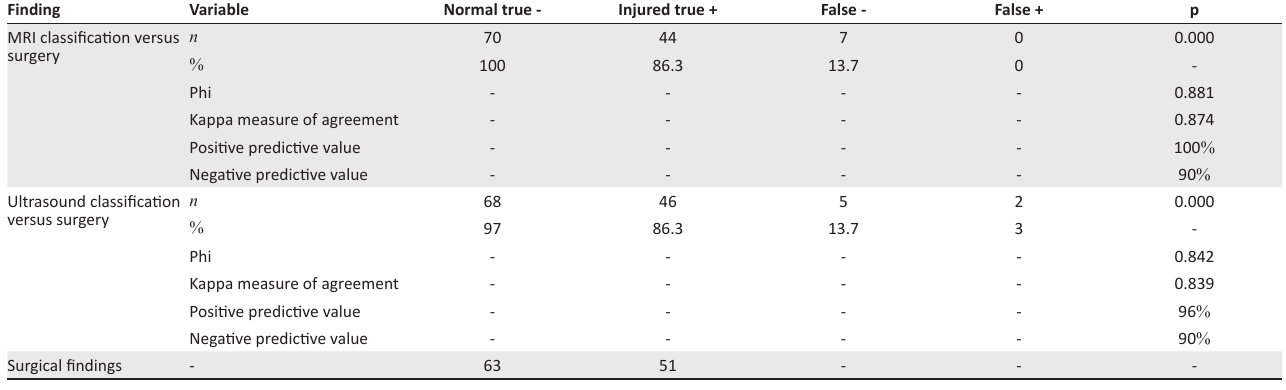
TABLE 5: Magnetic resonance imaging and ultrasound compared to surgical findings ( n = 114). Finding